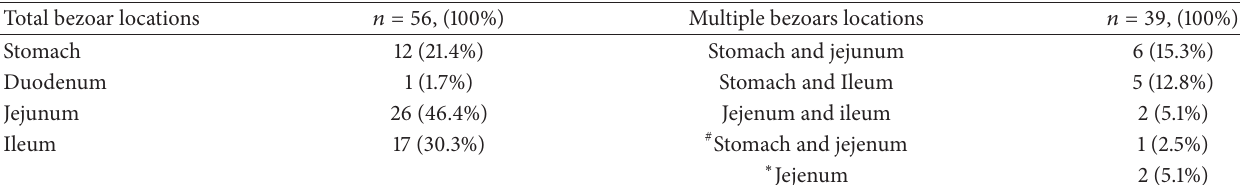
Table 1: Total bezoars and multiple bezoar locations.